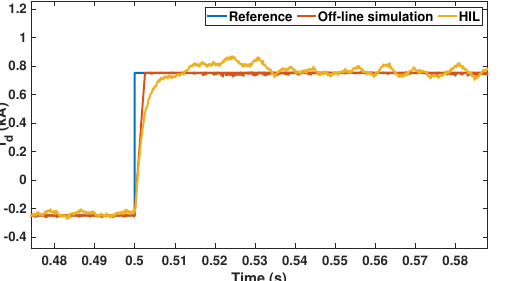
Figure 18. Experimental results of i d using the proposed method subjected to active current change under weak grid conditions.